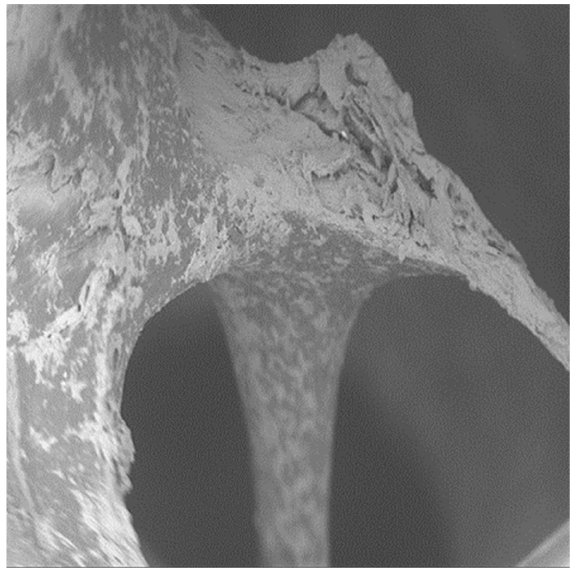
Figure 6. Control group sample surface.